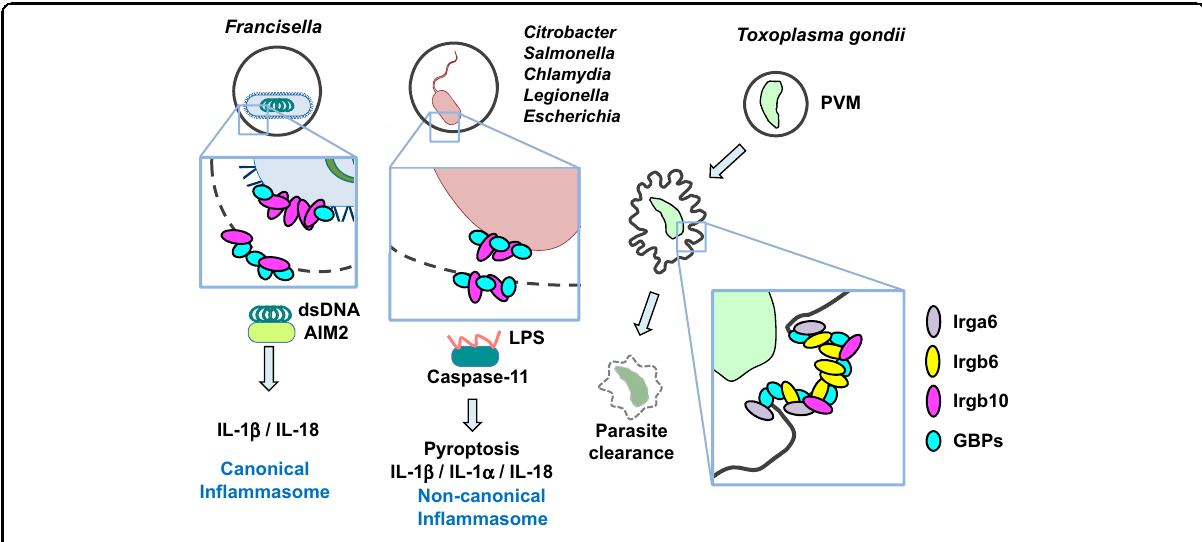
Fig. 3 IFN-inducible GTPase-dependent cell-autonomous immunity to intracellular pathogens. Francisella is Gram-negative bacterium that resides within a phagosome called the Francisella -containing phagosome (FCP), which is an initial vacuolar compartment. DNA from Francisella is somehow released into the cytosol and is recognized by AIM2, which is a cytosolic sensor that recognizes DNA, following the activation of the canonical in fl ammasome. Some bacteria, such as Salmonella and Citrobacter , are also Gram-negative bacteria and remain in the vacuoles in the host cytosol. LPS from these bacteria somehow binds to caspase-11 and then activates noncanonical in fl ammasomes. IRGs and GBPs accumulate on PVs of T. gondii , bacteria-containing vacuoles or bacterial cell membranes of various intracellular bacteria to eliminate pathogens and subsequently induce activation of the in fl ammasome. The function of each IRG and GBP on vacuoles is not fully